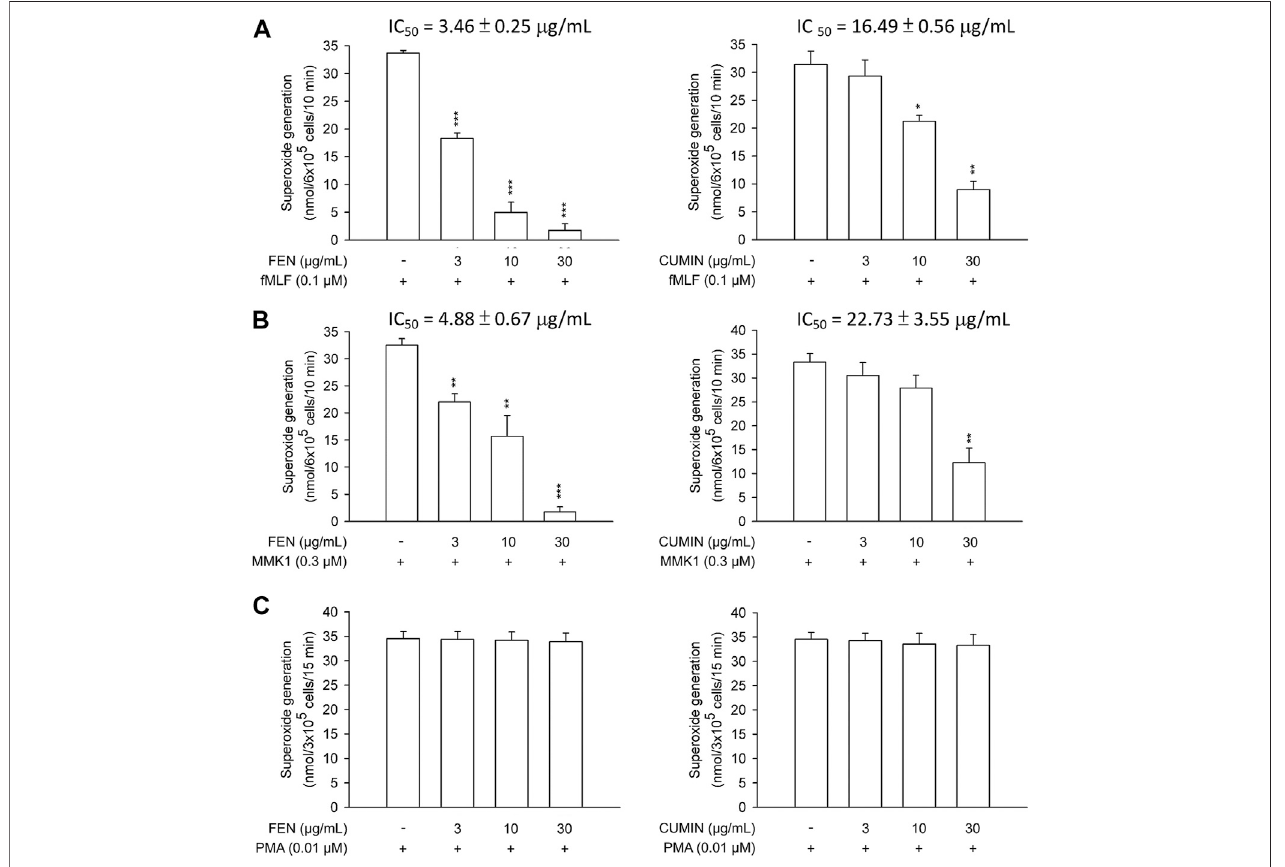
FIGURE1| Effectsoffennelvolatileoil(FEN)(leftpanel)andcuminvolatileoil(CUMIN)(rightpanel)onrespiratoryburstinhumanneutrophilsusingvariousinducers. Human neutrophils were incubated with 0.1% DMSO (as control), fennel or cumin volatile oils for 5 min, and then activated by (A) fMLF, (B) MMK1, or (C) PMA in the presence of CB (except PMA) for another 10 min (details in Measurement of Superoxide Generation ). Superoxide anion generation was detected by cytochrome c reduction spectrophotometrically at 550 nm. Data are expressed as mean ± S.E.M. ( n (cid:2) 3). * p < 0.05; ** p < 0.01; *** p < 0.001 compared with the control (inducer